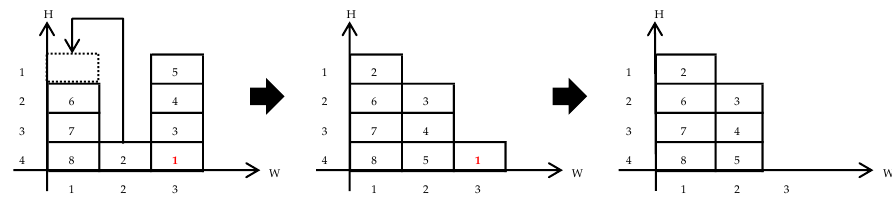
Figure 5. Representation of the use of rule Rr 8